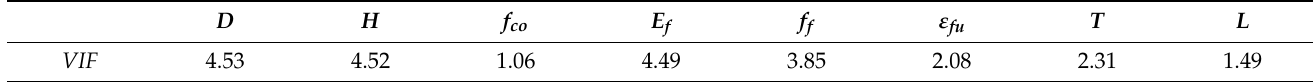
Table 3. Values for the VIF .